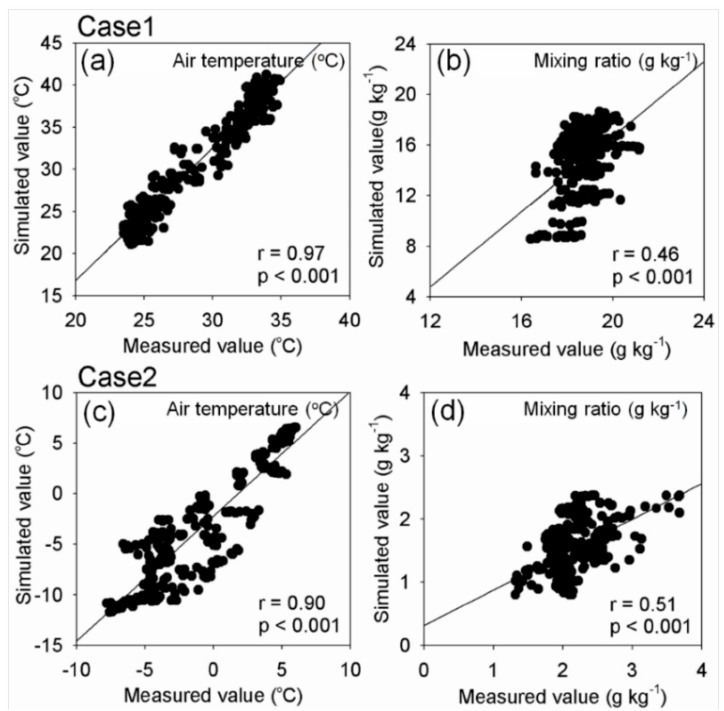
Figure 4. Scatter plots of simulated and observed hourly air temperature at 2 m ( a , c ) and mixing ratio ( b , d ) at 2 m for Case1 ( a , b ) and Case2 ( c , d ) of the Wide_River scenario. Each variable has di ff erent scales on the x and y